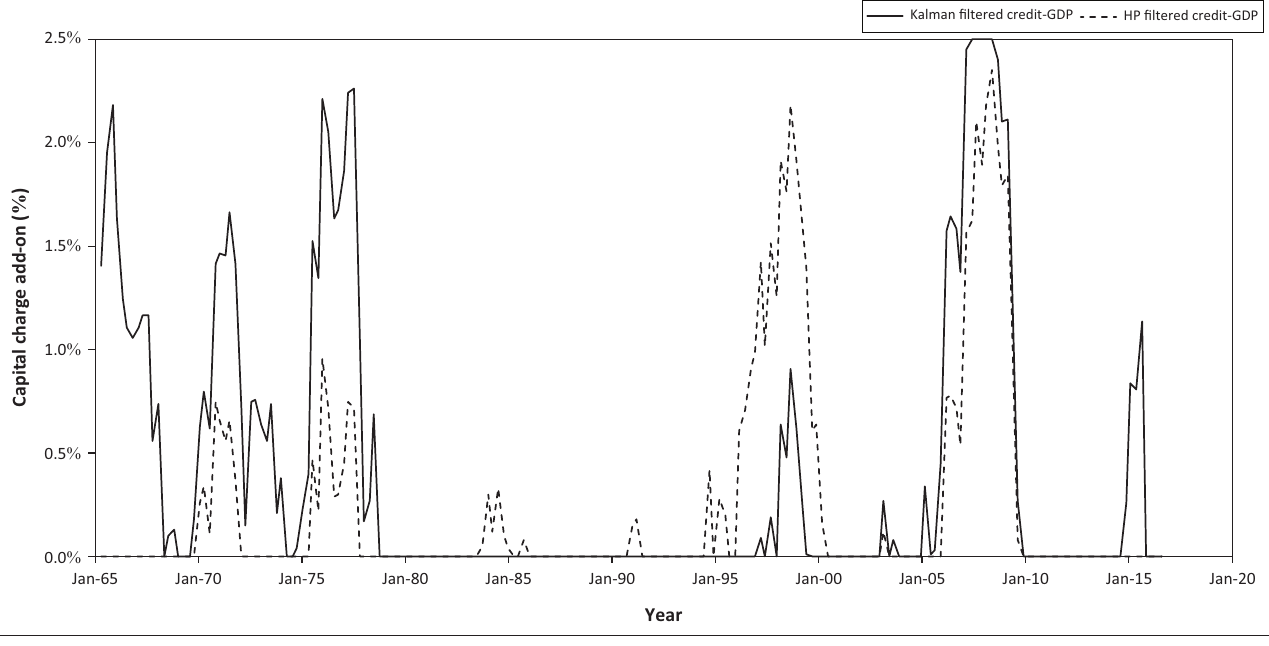
FIGURE 4: Historical Countercyclical Capital Buffer capital charge using the Hodrick–Prescott ( λ = 144 000) and Kalman